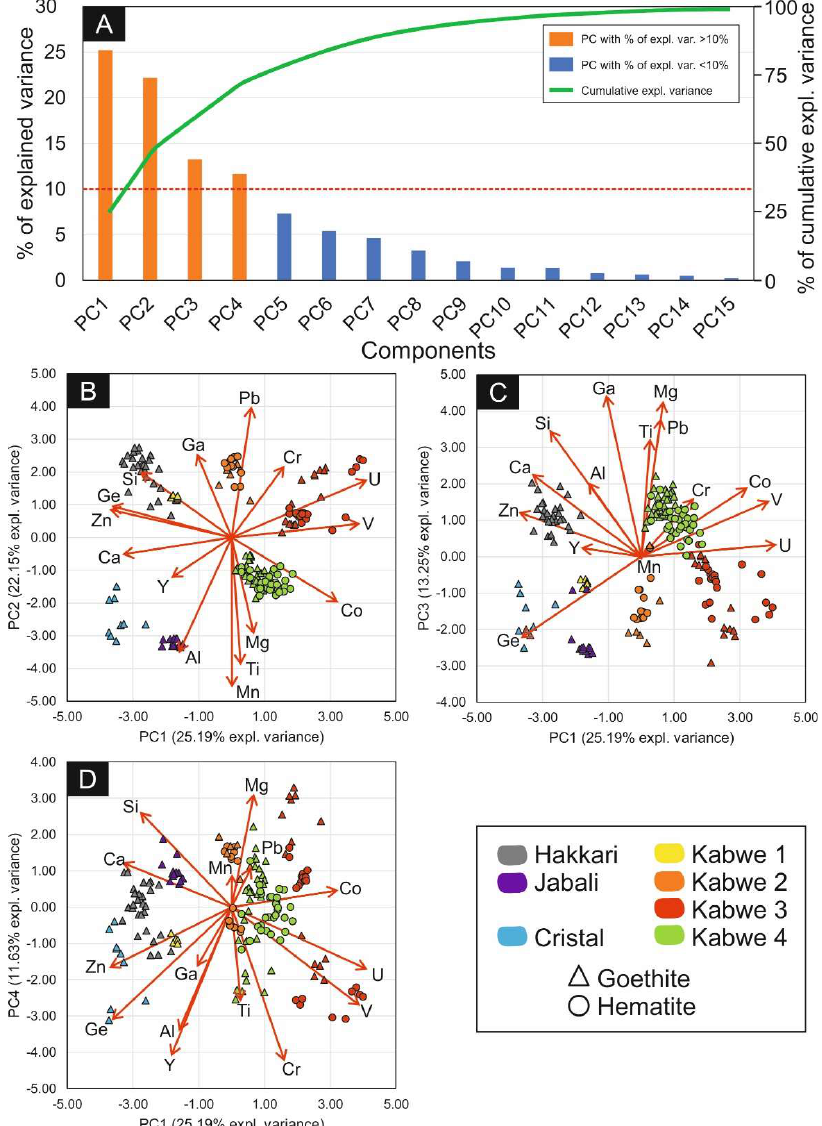
Figure 6. Results of the principal component analysis (PCA): ( A ) Scree plot showing the % of explained variance of each PC of the dataset: ( B ), ( C ) and ( D ) PC1 versus PC n biplots. Kabwe 1 = sample BM.1985, MI10900; Kabwe 2 = M1930; Kabwe 3 = OR5305 and BM.1985, MI29629 2/2; Kabwe 4 = BM.1985, MI29631 and OR5309.